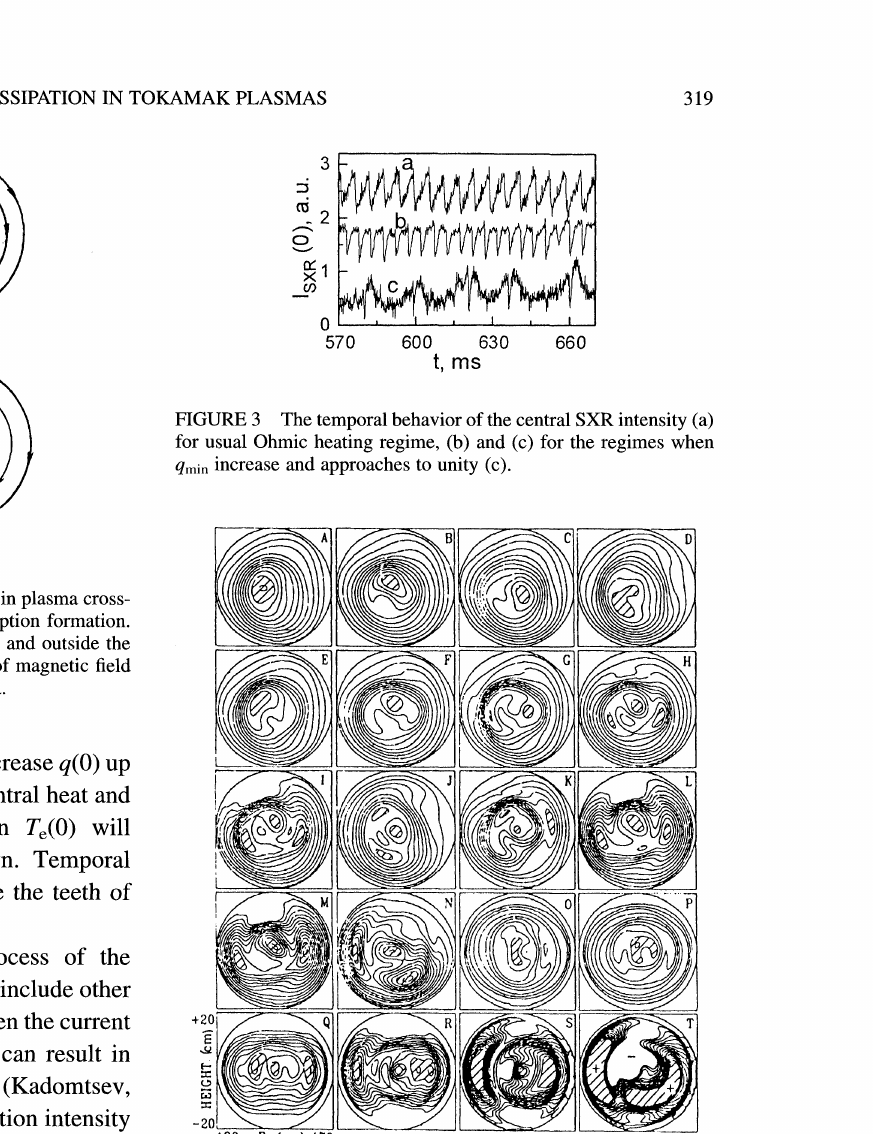
FIGURE 4 T-I0 tokamak. The result of the tomografic reconstruction of the SXR profiles for three angles of registration. The successive instance during the disruption development begins at the top left and goes in alphabetical order. The time resolution is 10 mks. The time between pictures is 60